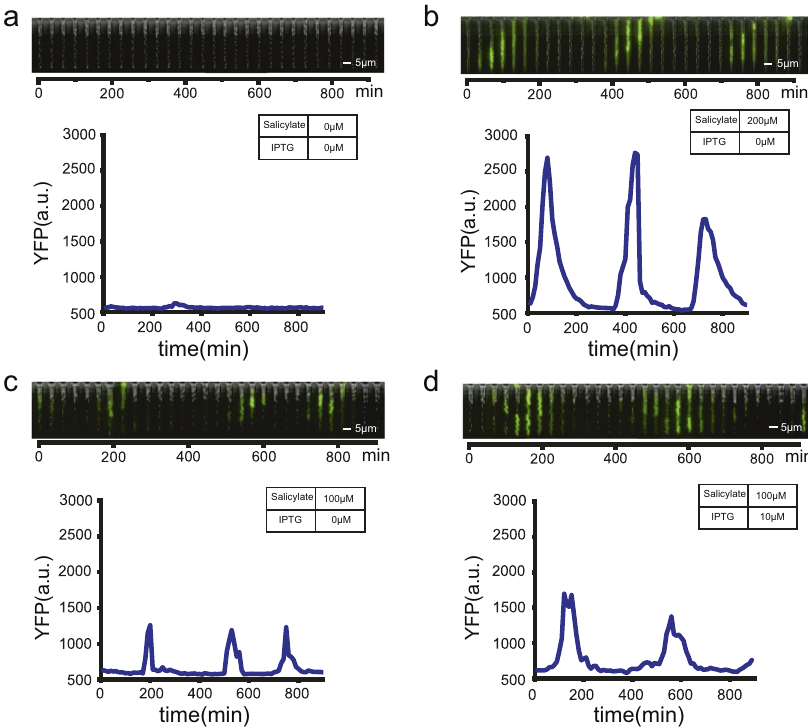
Fig. 2 Microscope images and the single-cell fl uorescence intensity curve of the oscillation in different inducer concentration combinations. a IPTG, 0 μ M; salicylate, 0 μ M, b IPTG, 0 μ M; salicylate, 200 μ M, c IPTG, 0 μ M; salicylate, 100 μ M, d IPTG, 10 μ M; salicylate, 100 μ M). Microscope images were merged by the phase contrast and YFP channels. The single-cell curves were drawn from the fl uorescence intensity of the mother cell in these channels. Each curve has at least one complete period of oscillation.